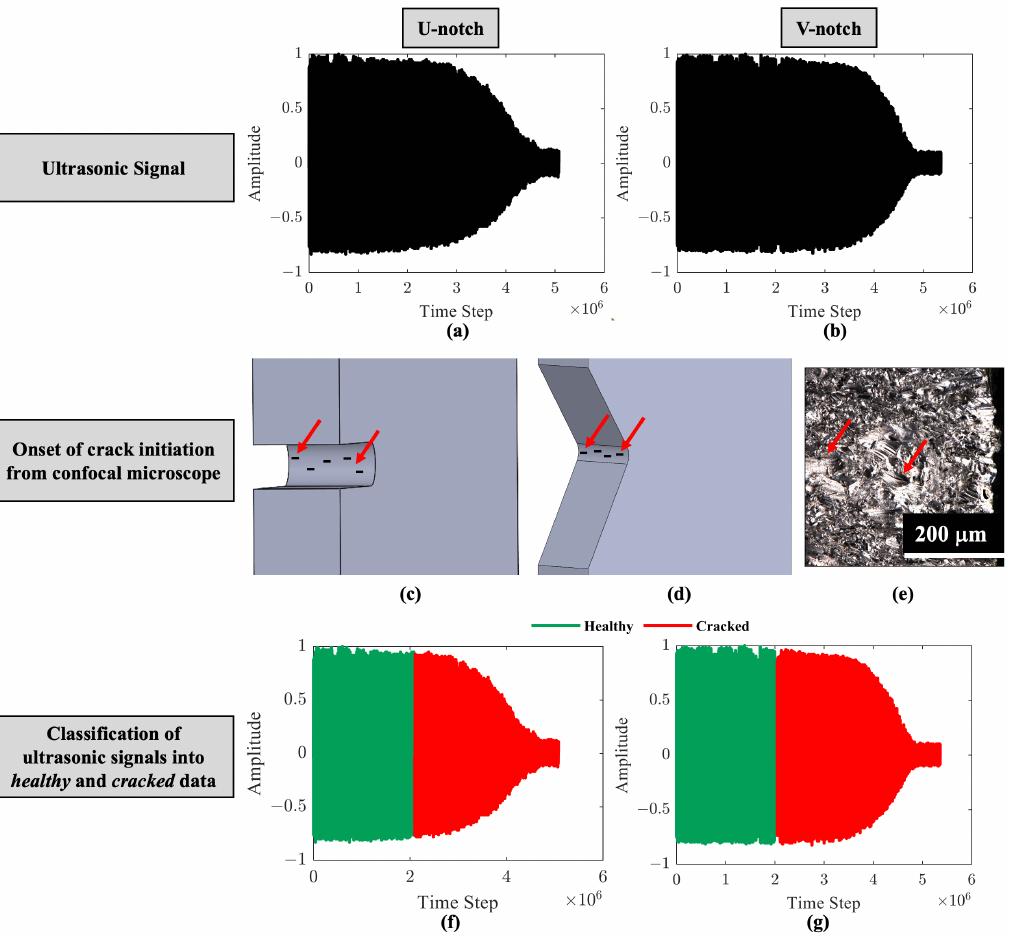
Figure 3. Concatenated signals during the entire duration of fatigue testing for a representative ( a ) U-notch specimen and ( b ) V-notch specimen. Representative initiation of fatigue cracks inside the notch root for ( c ) U-notch specimen and ( d ) V-notch specimen, and ( e ) an actual image from the V-notch. The red arrows in ( c – e ) represents the locations of short cracks. Binary classification into healthy and cracked labels of the ultrasonic signals for ( f ) U-notch specimen and ( g ) V-notch